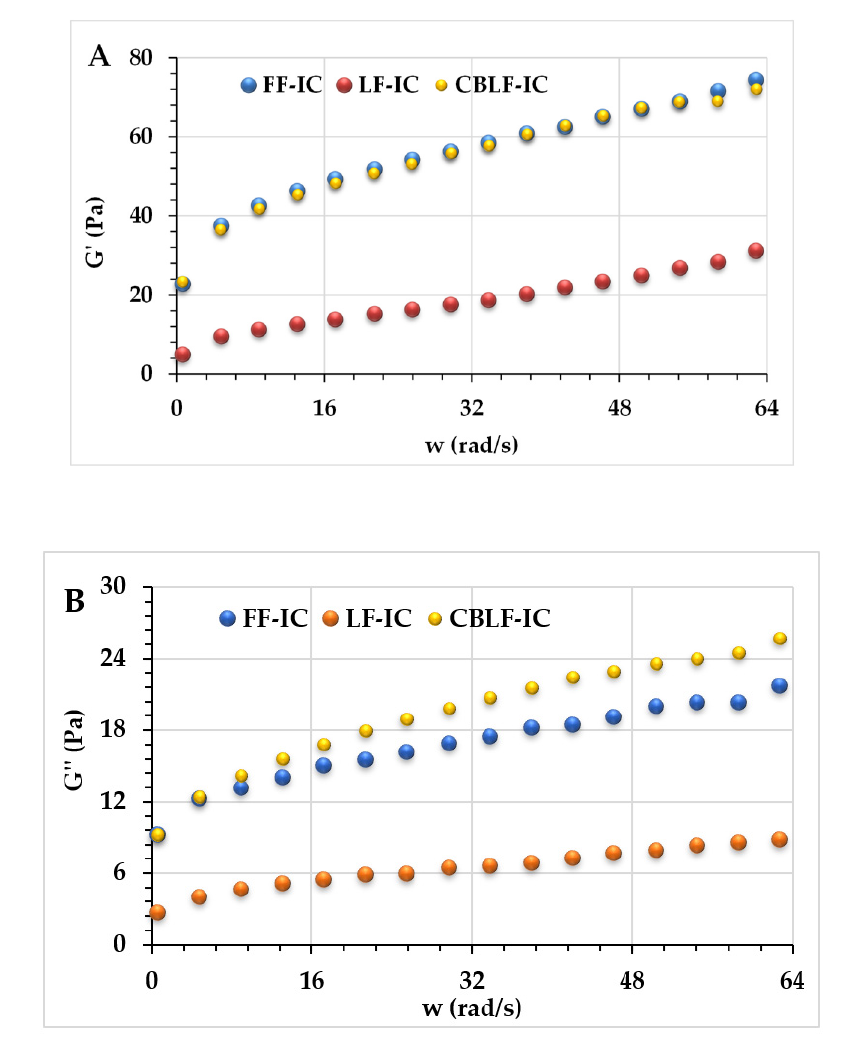
Figure 4. Dynamic rheological properties of the ice cream mixes. ( A ): Storage modulus ( G ' ) vs. ω , ( B ): loss modulus ( G '' ) vs. ω . FF-IC: full-fat ice cream, LF-IC: low-fat ice cream, CBLF-IC: low-fat ice cream with chia seed oil by-product.